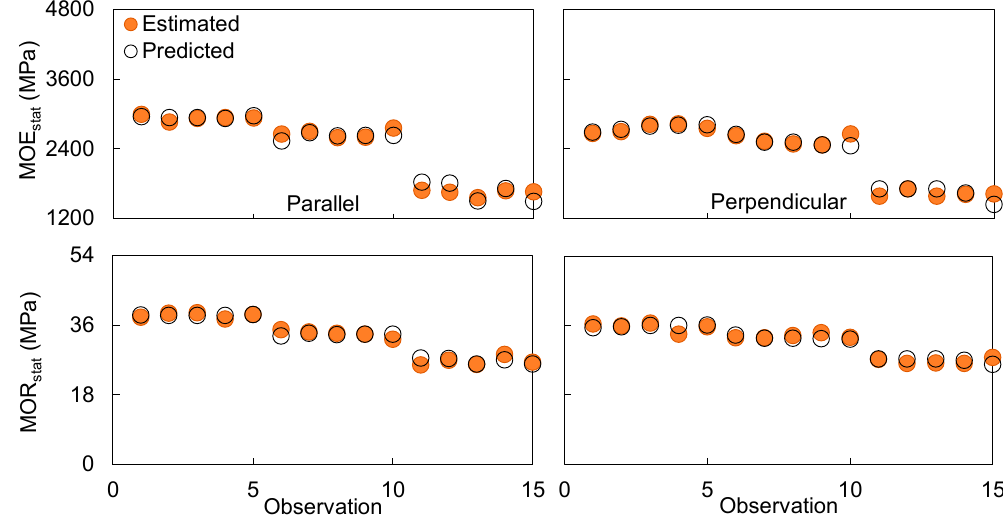
Figure 6. Estimated and predicted values of MOE stat and MOR stat for Medite Tricoya ® MDF samples conditioned at three different climatic conditions.